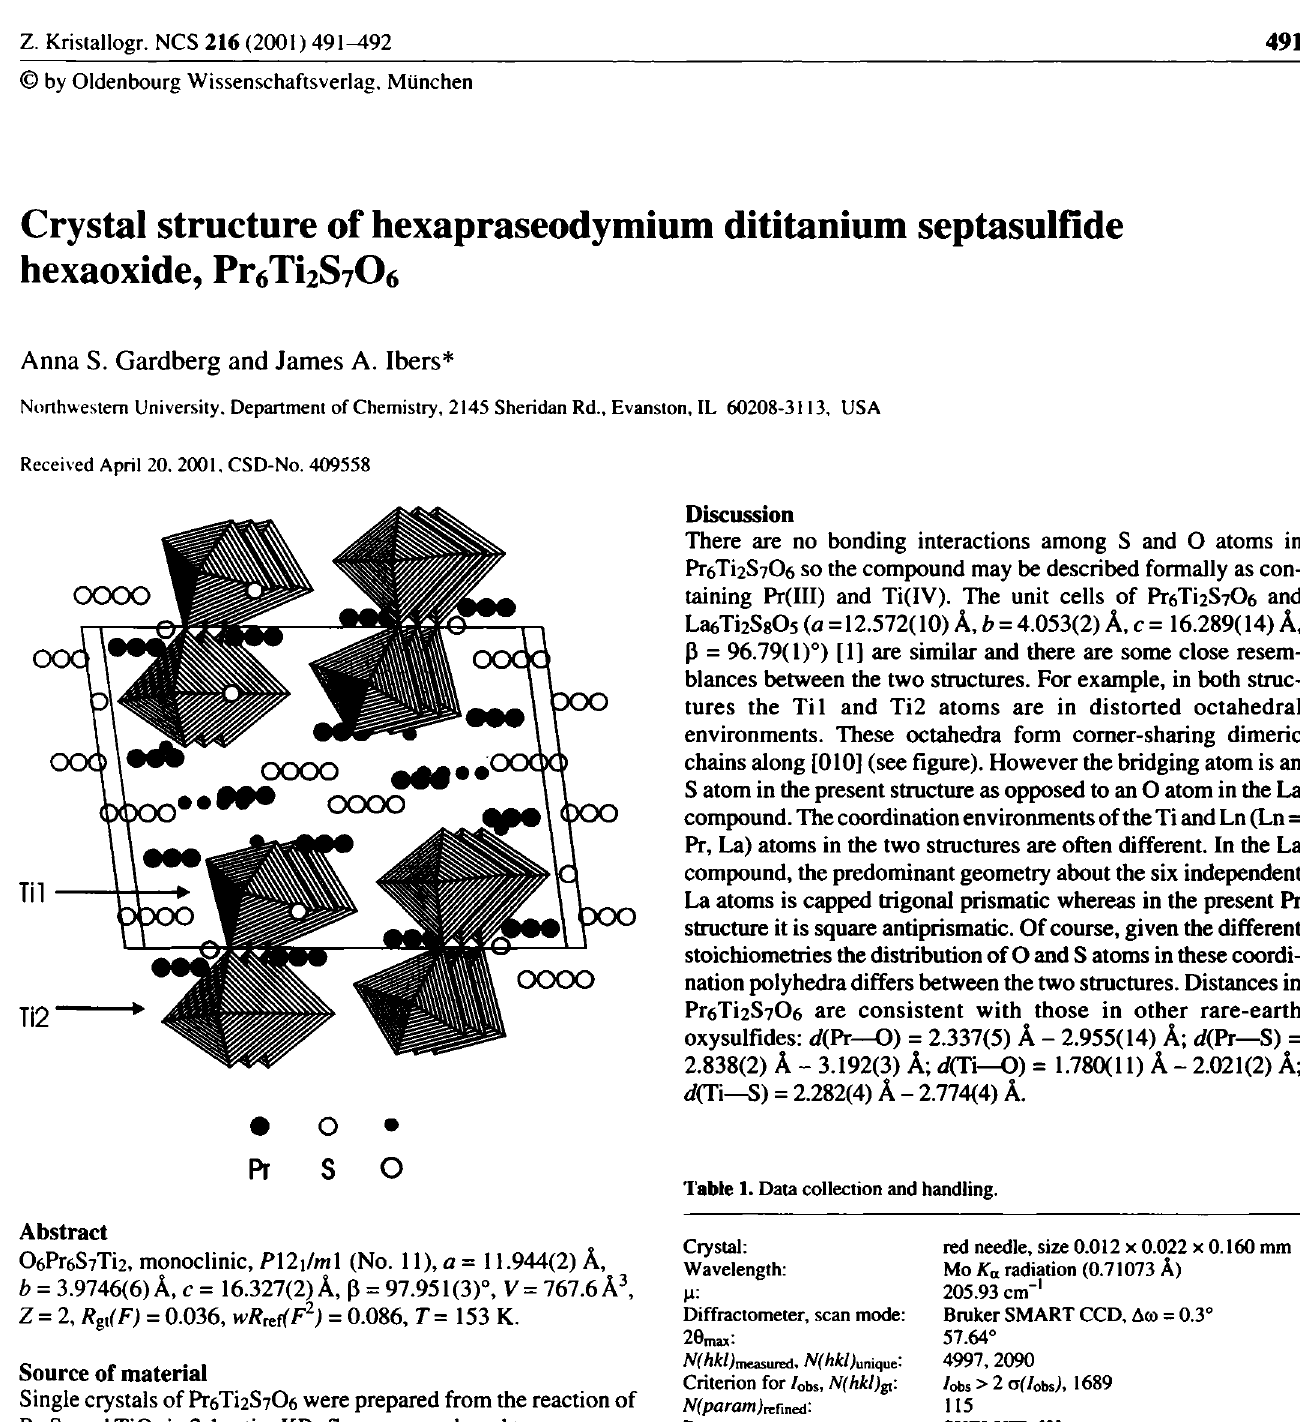
Table 2. Atomic coordinates and displacement parameters (in Ä 2